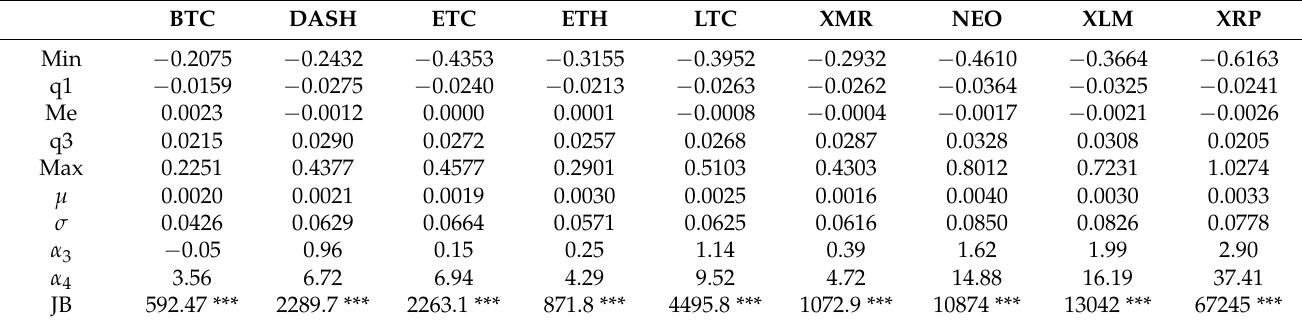
Table 1. Descriptive statistics for the selected cryptocurrencies from 1 January 2017 to 11 February